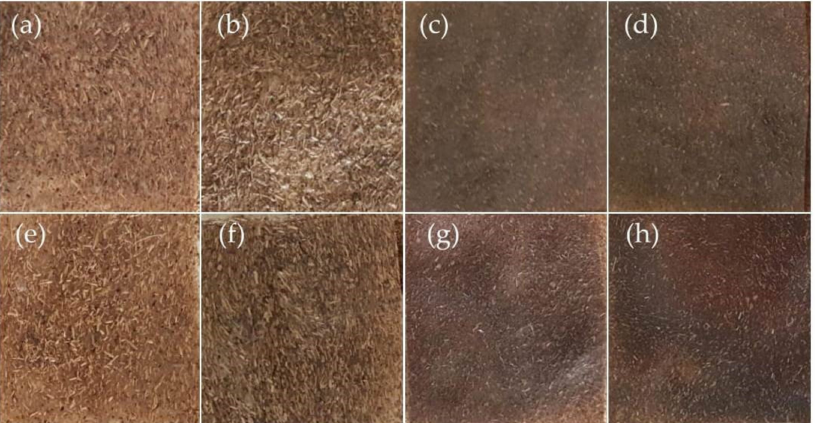
Figure 4. Images of materials obtained in the tests: ( a ) DG7(05); ( b ) DG14(05); ( c ) DG7(01); ( d ) DG14(01); ( e ) DG7(05); ( f ) DG14(05); ( g ) DG7(01); ( h )